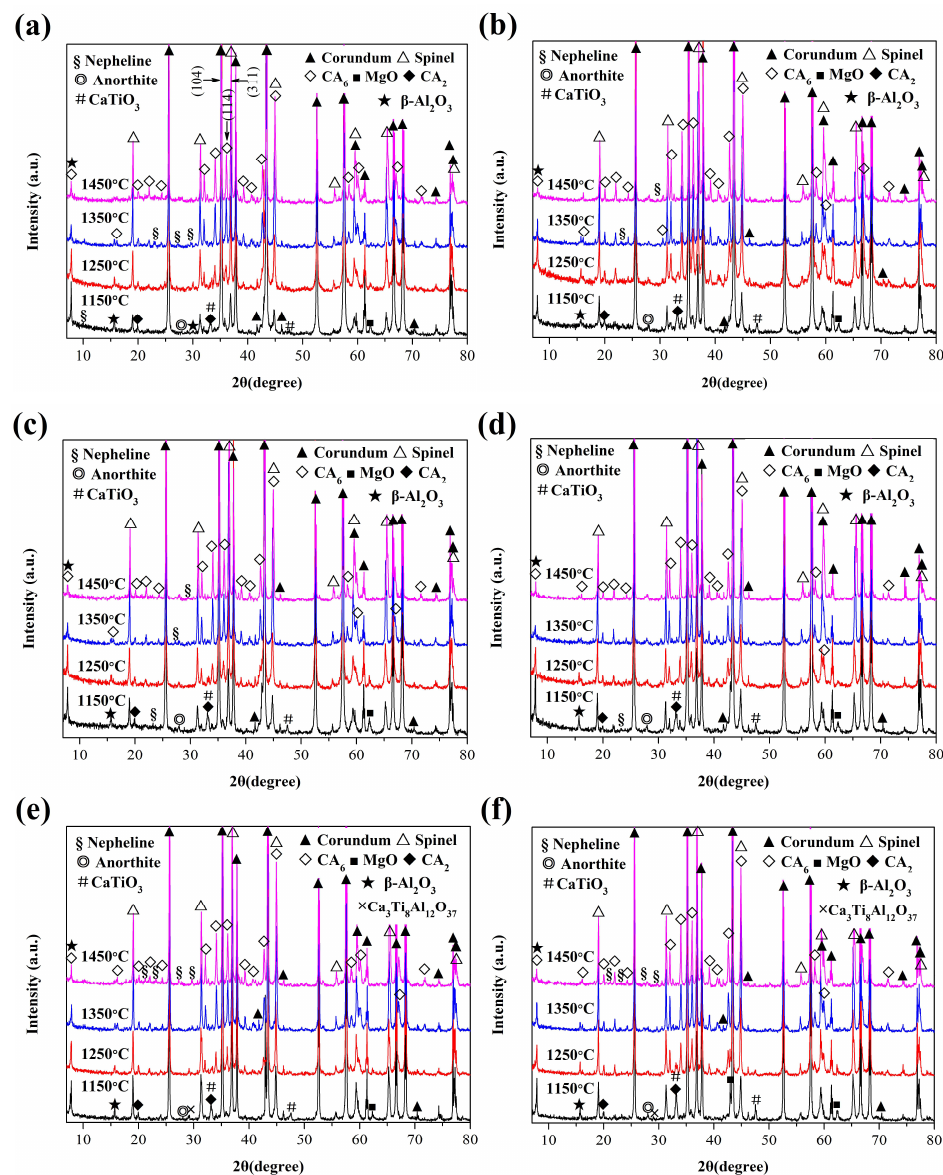
Figure 1. XRD patterns of the castables with the addition of different Ti-bearing compounds after calcination at different temperatures: ( a ) NT1, ( b ) NT2, ( c ) CT1, ( d ) CT2, ( e ) MT1, and ( f ) MT2. Because the formation of a solid solution would cause a change of the lattice param- eters, the variations of the diffraction peak positions for spinel and CA 6 were compared to evaluate the doping level of titanium, as presented in Figure 2. The (104) plane of co- rundum was set as the base plane, and the selected crystal planes of spinel and CA 6 were (311) and (114), respectively. Basically, the diffraction peaks of spinel gradually shifted to higher angles as the temperature increased, as presented in Figure 2a. This could be ex- plained by the formation of Al-rich spinel caused by the aluminum substitution on the